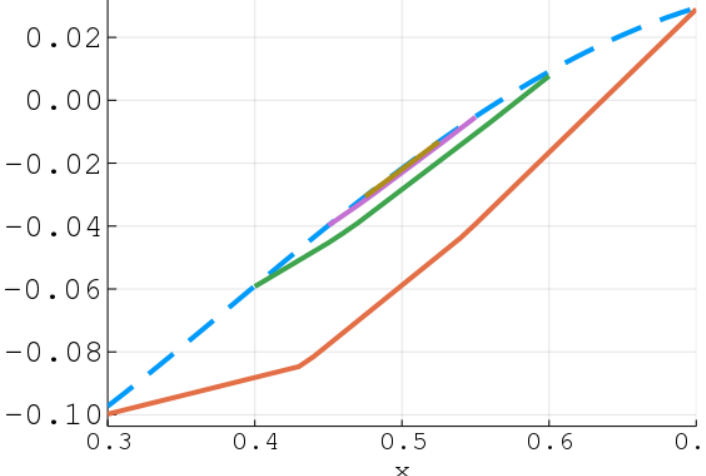
Figure 1. A plot of the function f in Example 1 (dashed) and its associated subgradient-cutting relaxations (solid) on intervals of the form [ 0.5 − (cid:101) ,0.5 + (cid:101) ] for 0 < (cid:101) < 0.2. With φ denoting the relaxation of f constructed on X ( (cid:101) ) , Figure 2 presents a log-log plot of the X ( (cid:101) ) ( f ( x ) − φ ( x )) against the width of the interval X ( (cid:101) ) , together with a maximum discrepancy sup X ( (cid:101) ) x ∈ X ( (cid:101) ) reference line with a slope of 2. The agreement between these two suggests that the convex relaxations φ x ( (cid:101) ) exhibit second-order pointwise convergence to f as (cid:101) → 0 + .